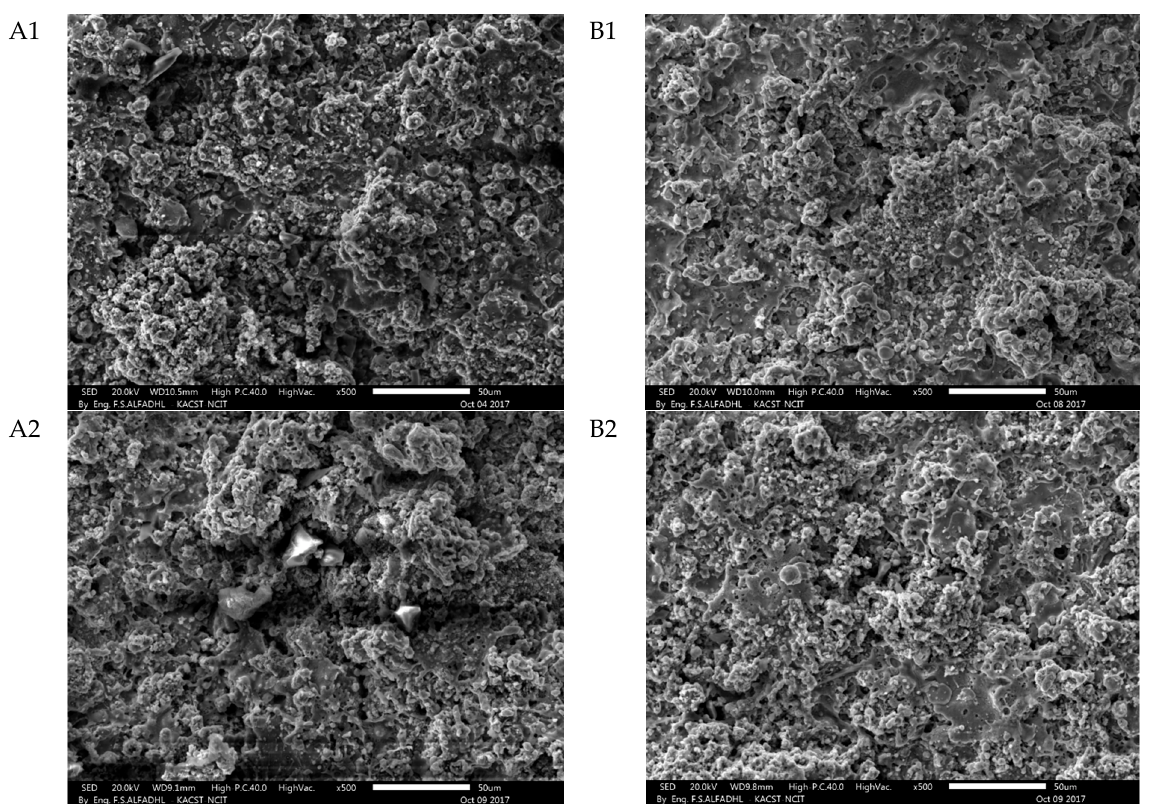
Figure 5. Secondary electron SEM images of the surface of the SiC-ZrB 2 for A1, B1, A2 and B2 coatings taken at 20 kV electron acceleration voltage at 500× (scale bar = 50 μ m) low magnifications.